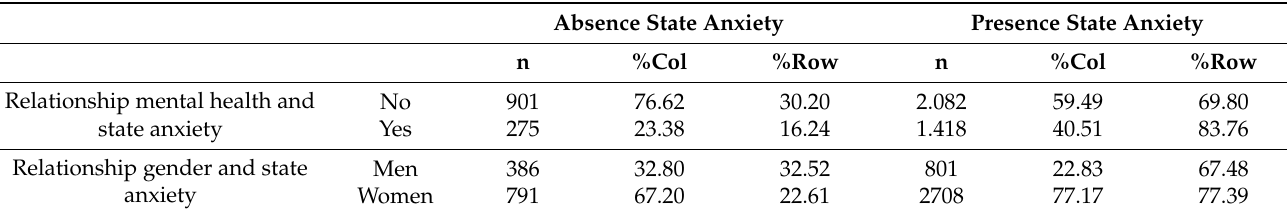
Table 7. Relationship between state anxiety, gender, and mental health.